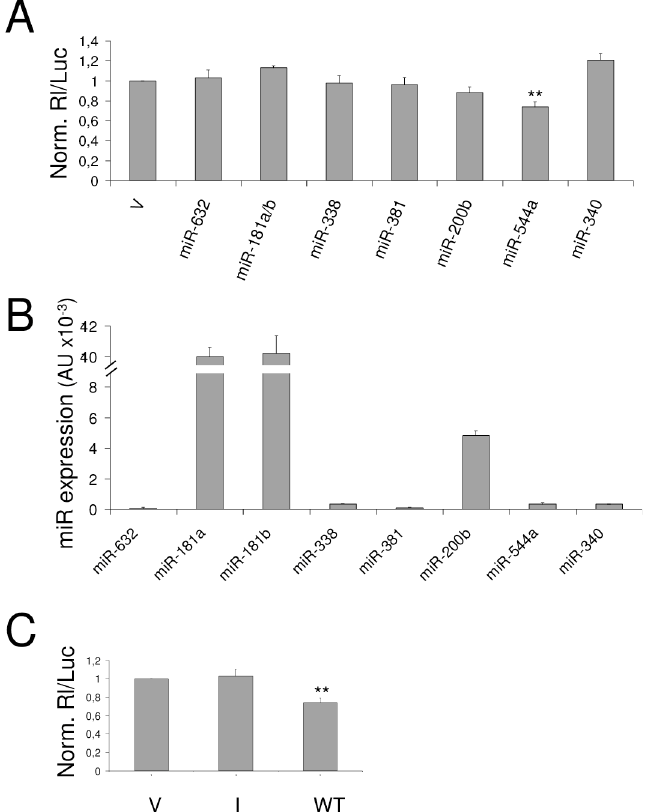
Fig 1. Testing of 3 ’ UTR SELK targets for responsiveness to human hepatic miRNAs in HuH-7 cell line. (A) The potential targets of indicated miRNAs were cloned in the reporter vector psiCheck2. One